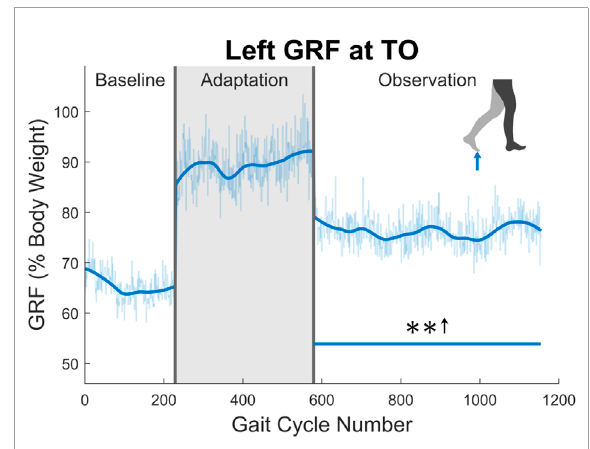
FIGURE 10 Maximum vertical ground reaction force between midstance and toe-off for the left leg in percent body weight. Significance is shown in the observation phase as compared to the baseline phase by the significance line. All significance testing was performed on “unsmoothed” data (seen in the lighter line). The darker line is the data smoothed by 2nd-degree polynomial local regression and was added only to allow the reader to more clearly see trends in the